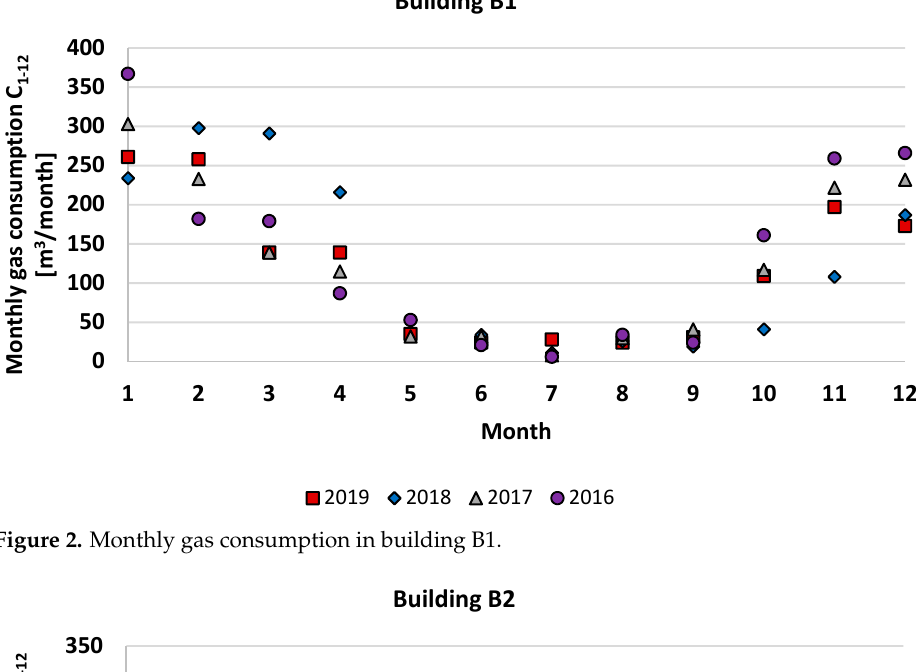
Figure 2. Monthly gas consumption in building B1.